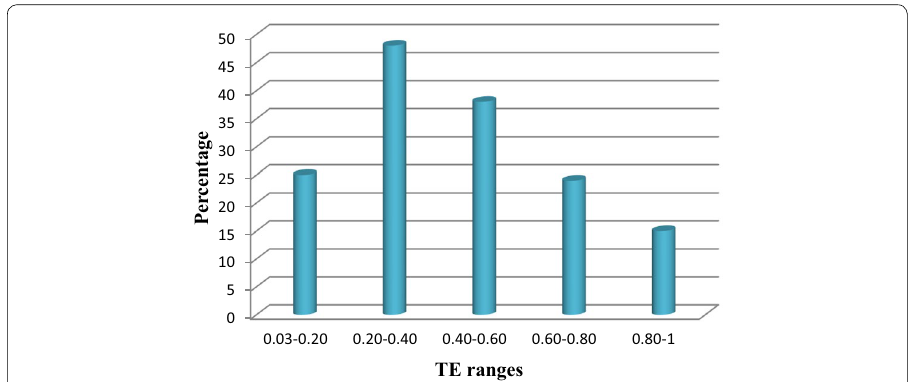
Fig. 2 Frequency distribution of technical efficiency (Source: Computed from Field Survey Data,